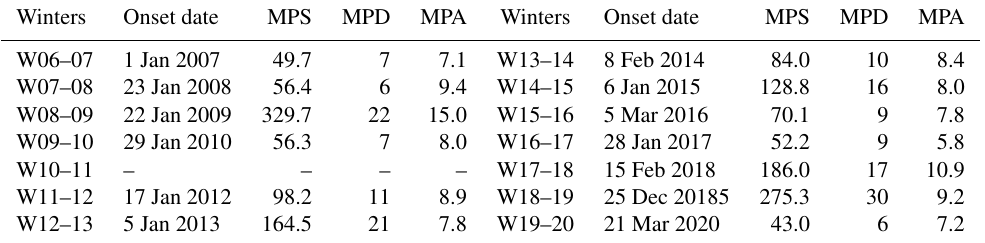
Table 4. SSW climatology summary 2006–2020 based on RO for main metrics (left half to W12–13; right half from W13–14), for enabling quantitative intercomparison to the results based on ERA5 as summarized in Table 3 (for definition and units of the parameters, see Table